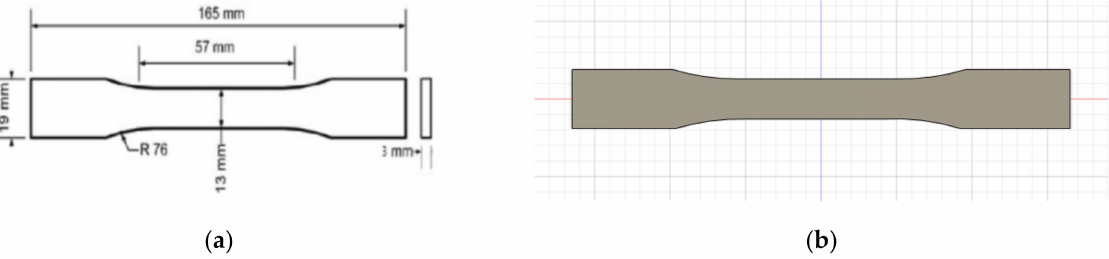
Figure 1. ( a ) Dimensions of ASTM D638 Type I and ( b ) 3D model of